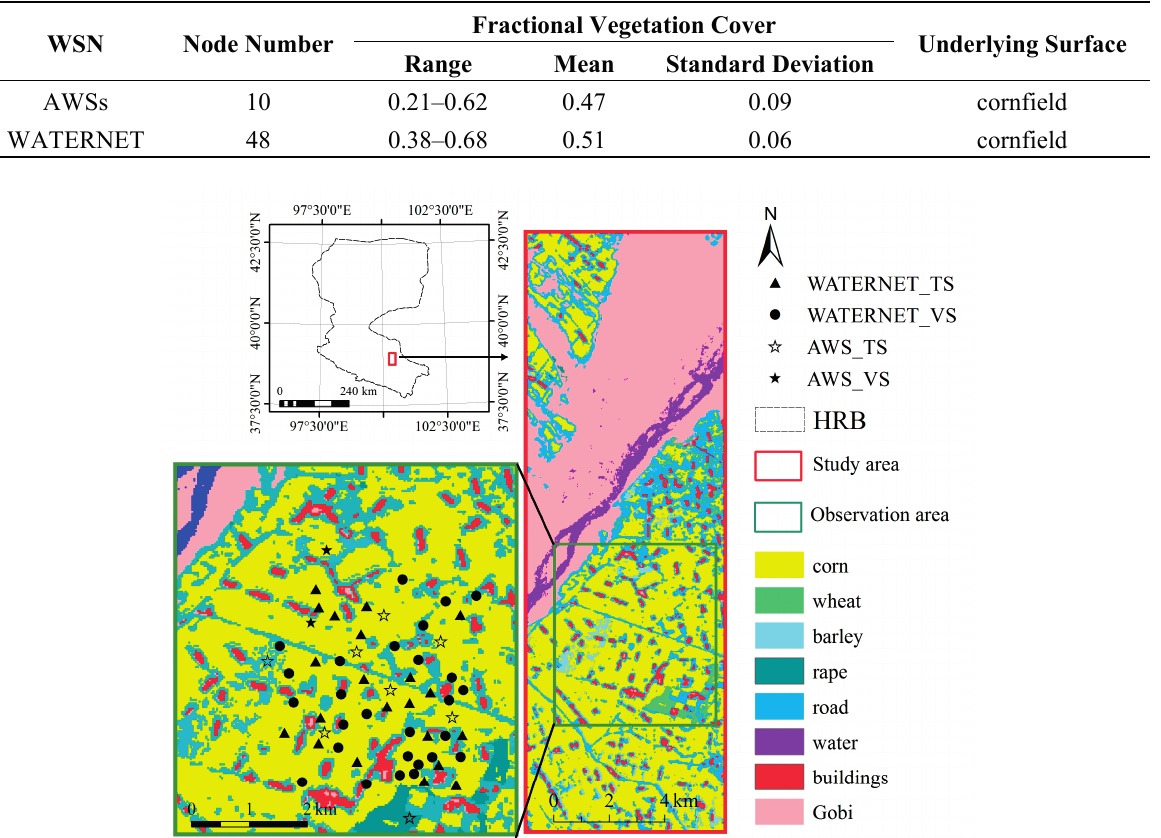
Figure 1. Land classification map of the study area with in situ SM measurement points (the WATERNET_TS and AWS_TS nodes are used as the training subsample, and the WATERNET_VS and AWS_VS nodes are used as the validation